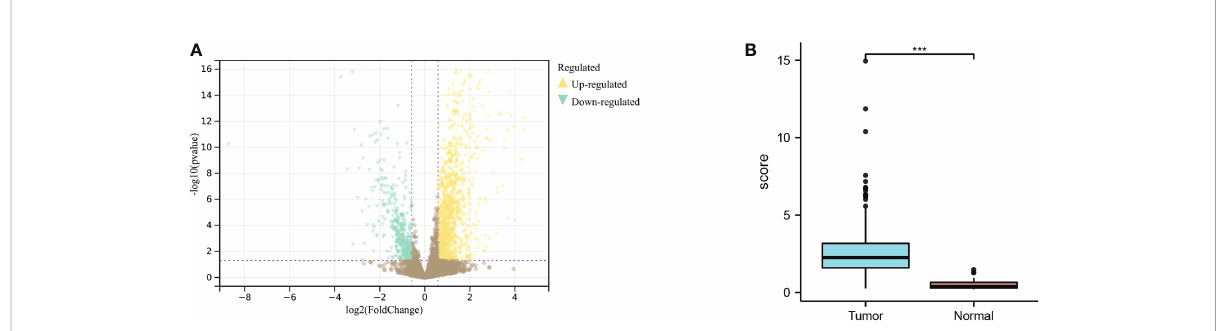
FIGURE 2 Differential analysis of TCGA dataset for gastric cancer. (A) Differential expression results of the TCGA dataset; yellow indicates upregulated genes, blue indicates downregulated genes. (B) . Analysis of MIR4435-2HG expression in gastric cancer tissues and normal tissues adjacent to cancer, blue indicates tumor, and red indicates normal tissue. *** indicates